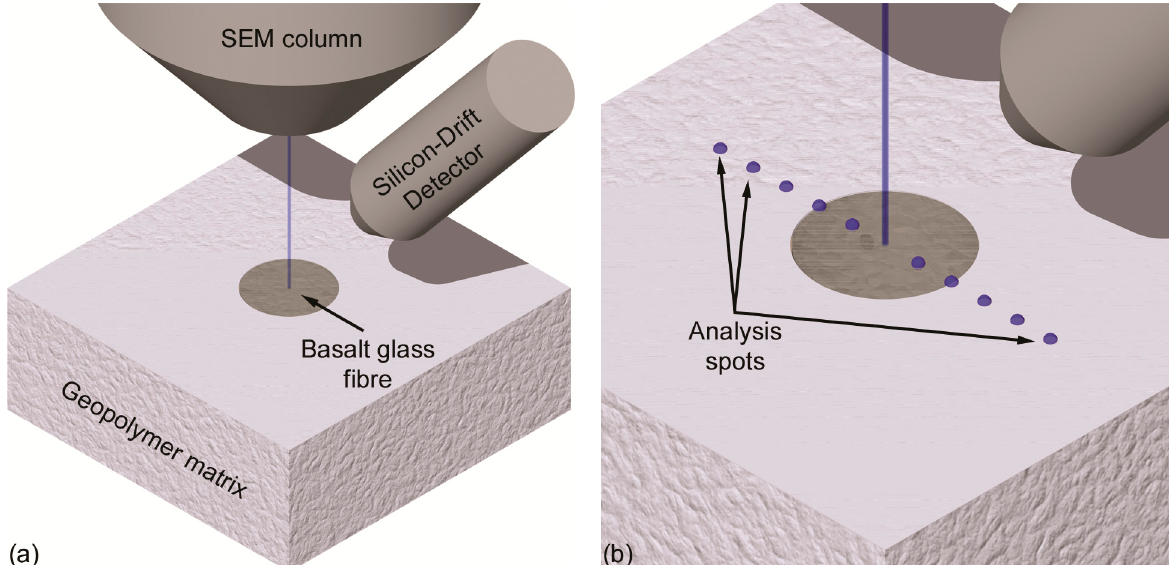
Table 1. Oxides mass fraction (wt%) of basalt-derived glass fibre.